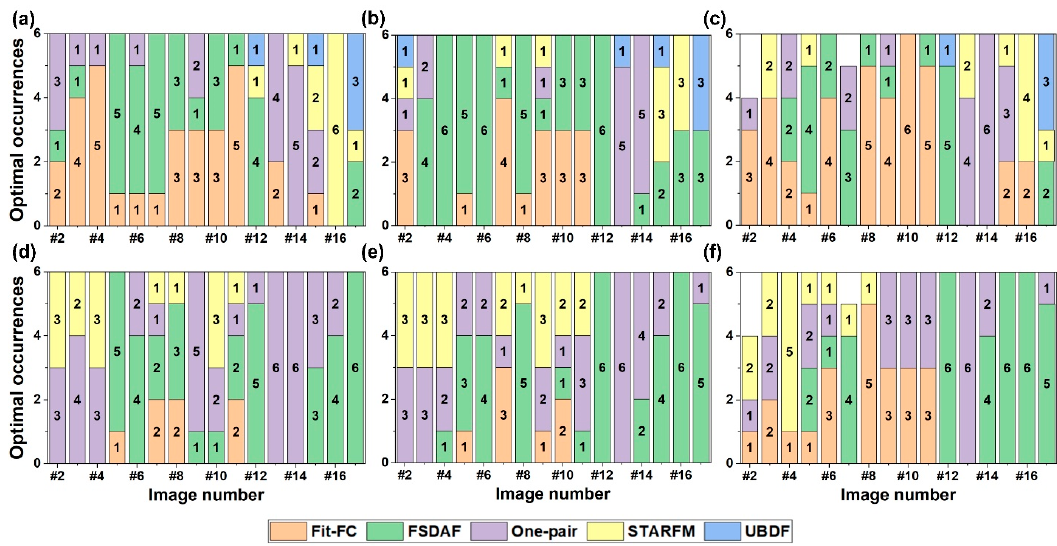
Figure 9. Occurrences of optimal STIF models for “HH” blocks ( a and d ), “HL” blocks ( b and e ) and “LH” blocks ( c and f ) evaluated using ERGAS (top row) and SSIM (bottom row) at the Coleambally site.